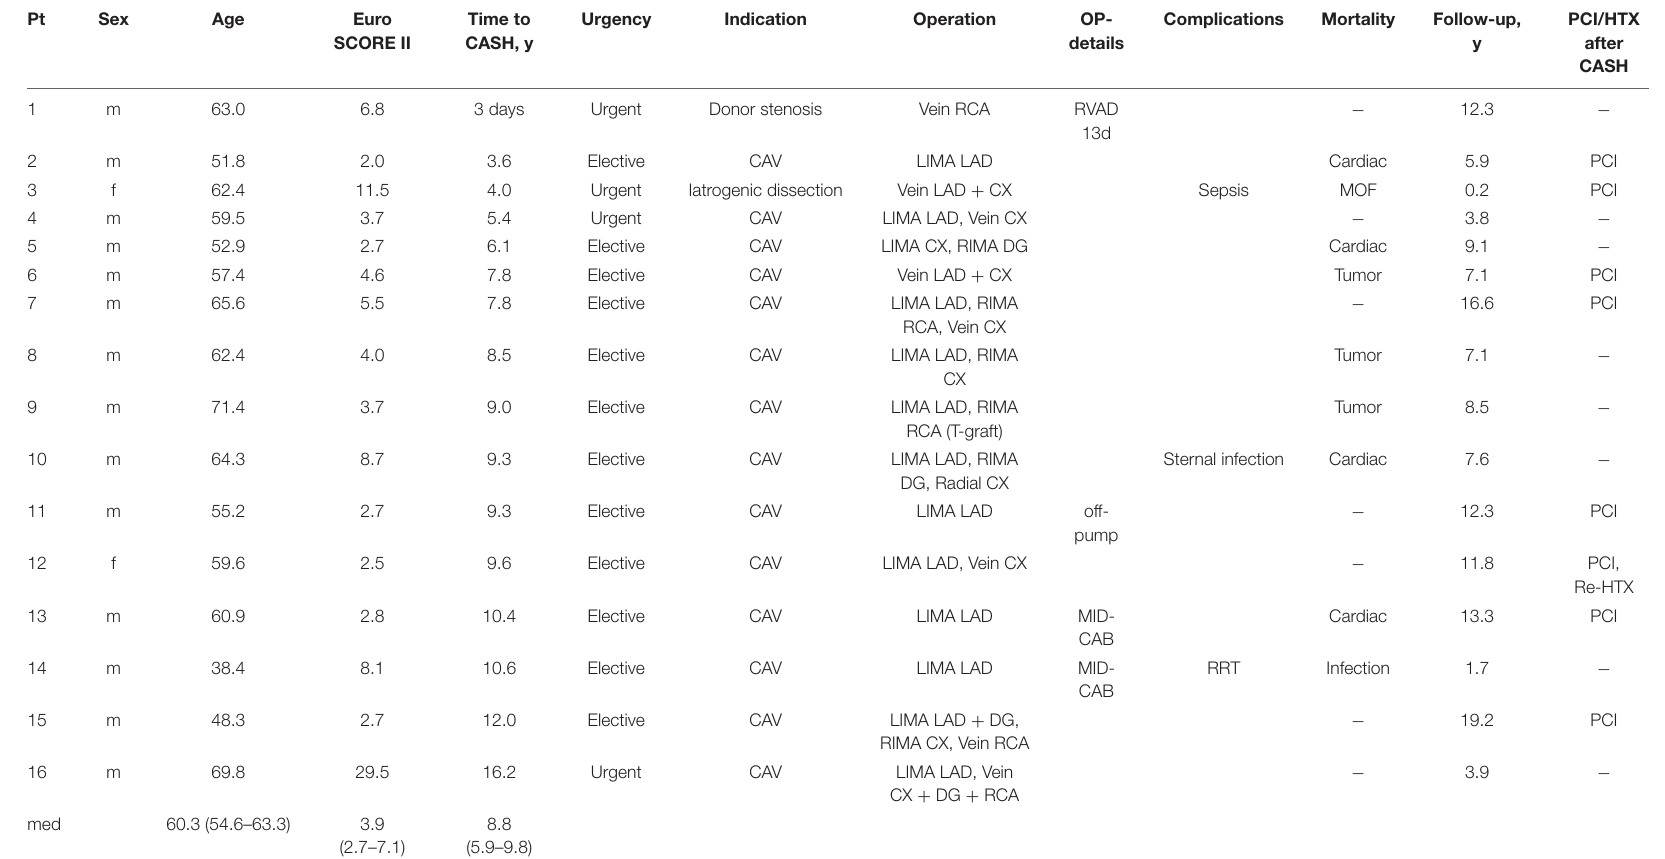
TABLE 6 | Coronary artery bypass graft